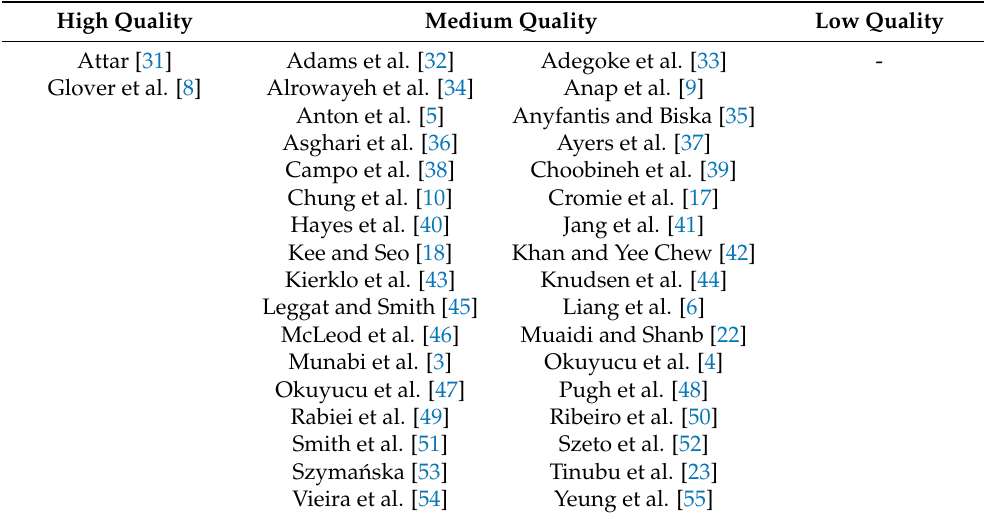
Table 1. Quality appraisal of the included studies according to the modified CONSORT 2010